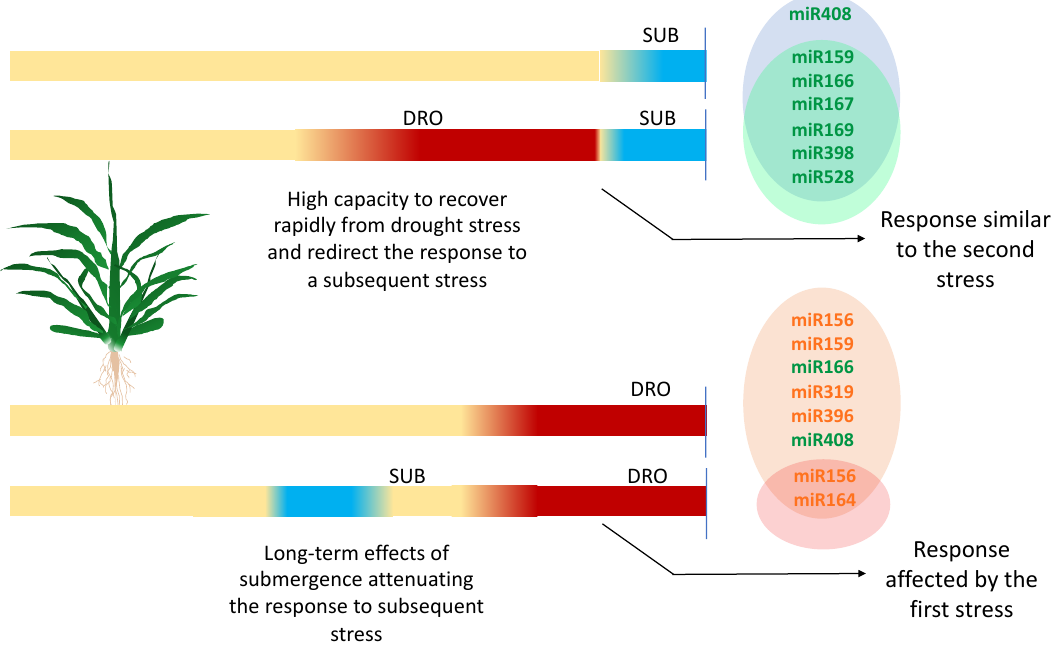
Figure 5. Hypothetical model of the response to alternated stress in teosinte. The influence of the first stress and the consequences in miRNA responsiveness to the second stress are indicated. Green, downregulated miRNAs; orange, upregulated